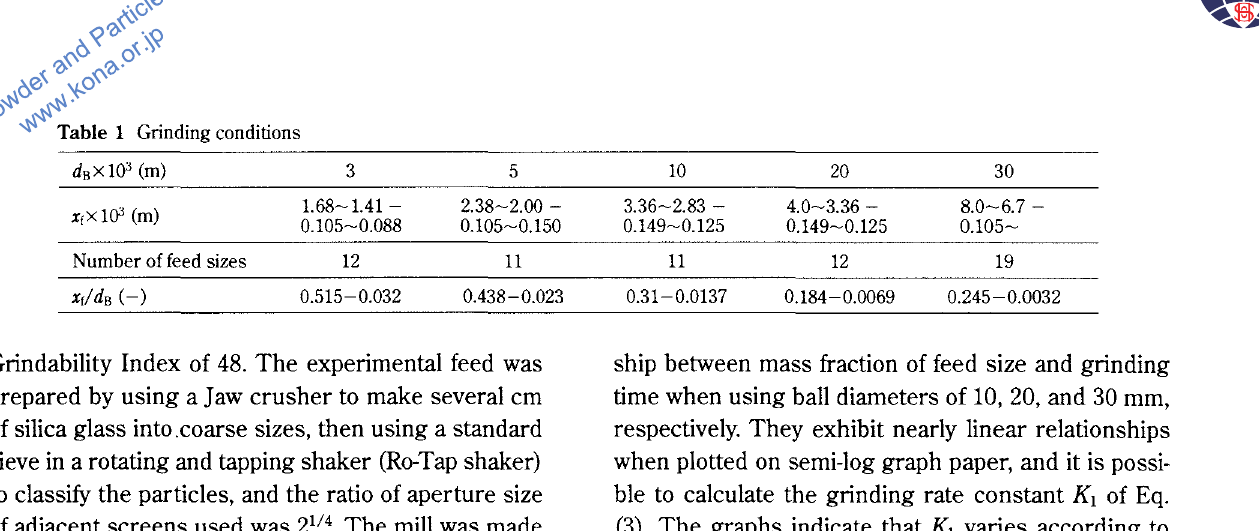
Fig. 2 First-order plots of feed fraction (d 8 =2x 10- 2 m)